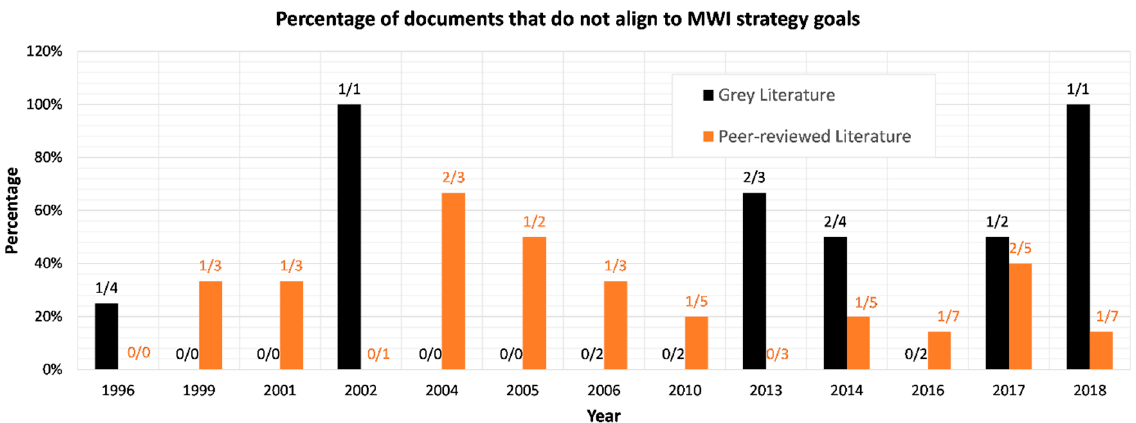
Figure 10. Percentage of studies that do not align with the MWI water strategy. The numbers above the bars represent the number of documents that do not align with MWI strategy and the total number of documents per year (the figure only represents the years, where the documents do not align with the MWI strategy goals).